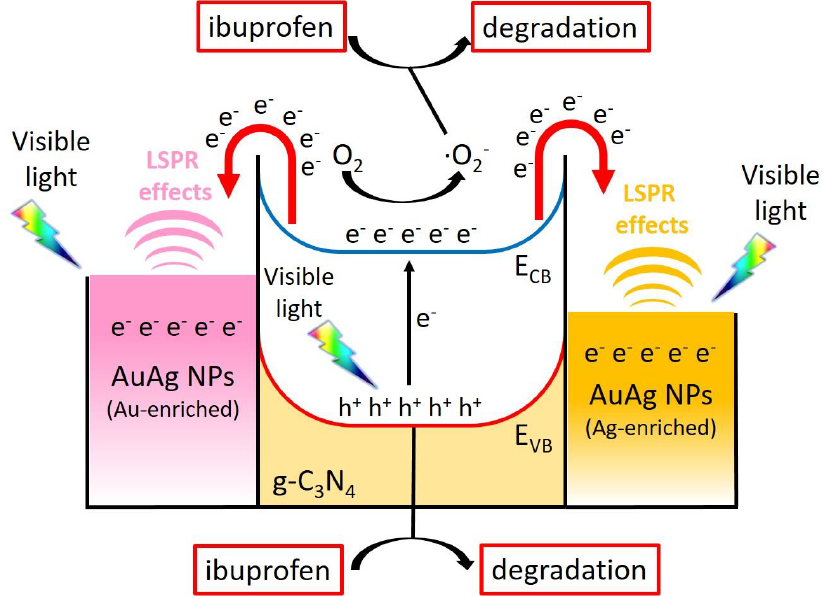
Figure 11. Schematic representation of the mechanism of degradation of ibuprofen through the plasmonic hot-electron injection from Au-enriched and Ag-enriched NPs and from electronic excitation of g-C 3 N 4 semiconductor.